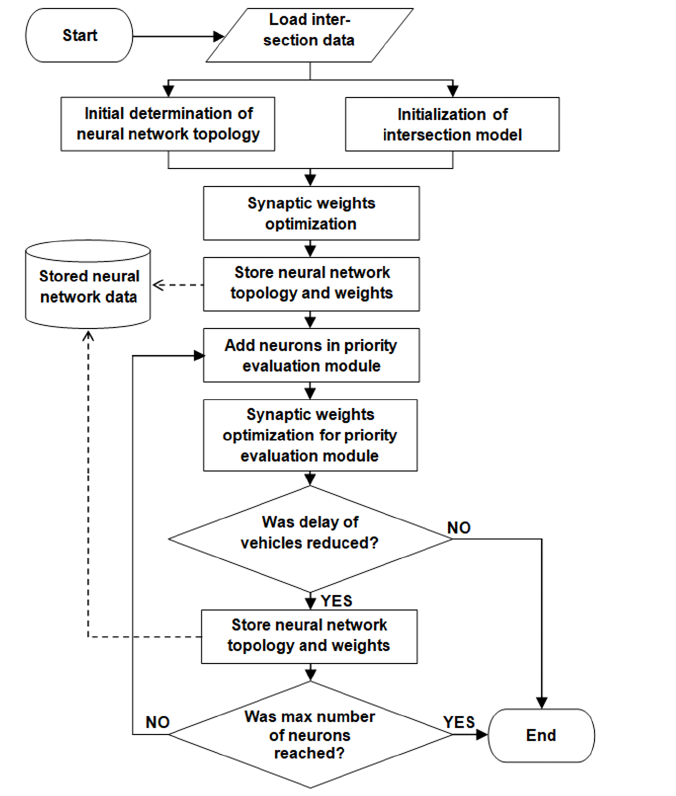
Figure 5. Overview of the neuroevolution